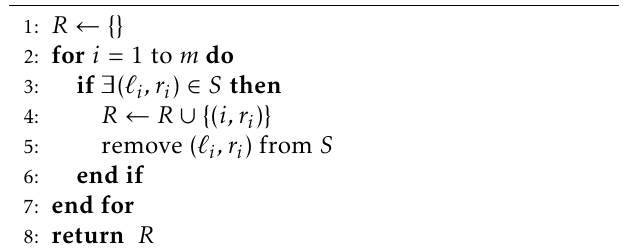
Algorithm 4 SERV ERP ROCESS ( (cid:96) 1 , . . . , (cid:96)